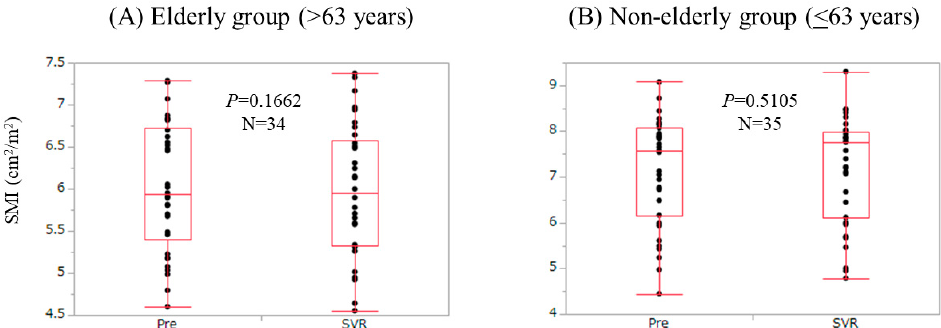
Figure 5. Changes in SMI according age. Patients with the age of >63 years (the median value in our cohort) were defined as the elderly group ( n = 34), while those with the age of ≤ 63 years were defined as the non-elderly group ( n = 35). ( A ) In the elderly group, SMI at SVR did not significantly increase as compared with baseline levels ( p = 0.1662); ( B ) In the non-elderly group, SMI at SVR did not significantly increase as compared with baseline levels ( p = 0.5105).